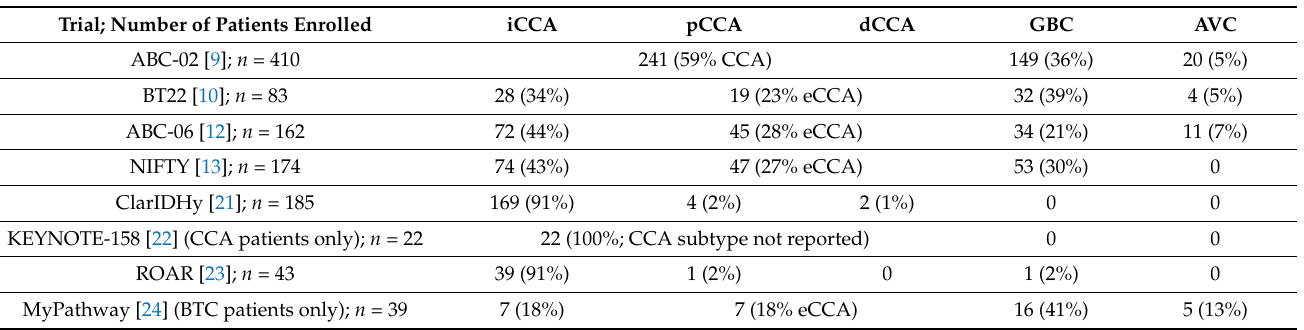
Table 1. Representation of subtypes of biliary tract cancer in selected clinical trials of chemotherapy and targeted